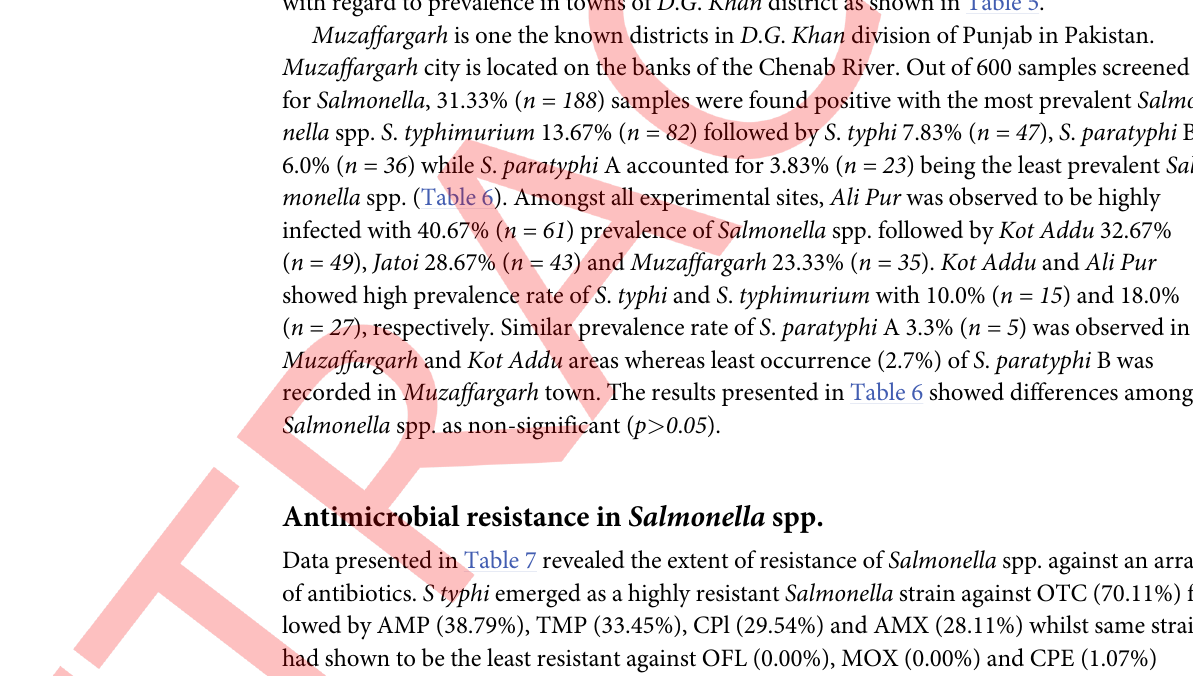
Table 5. Prevalence (%) of Salmonella spp. isolated from raw milk and environment samples in dairy farms from district D . G . Khan . Towns TS PS S . typhi S . paratyphi A S . paratyphi B S . typhimurium Total Prevalence n (%) n (%)